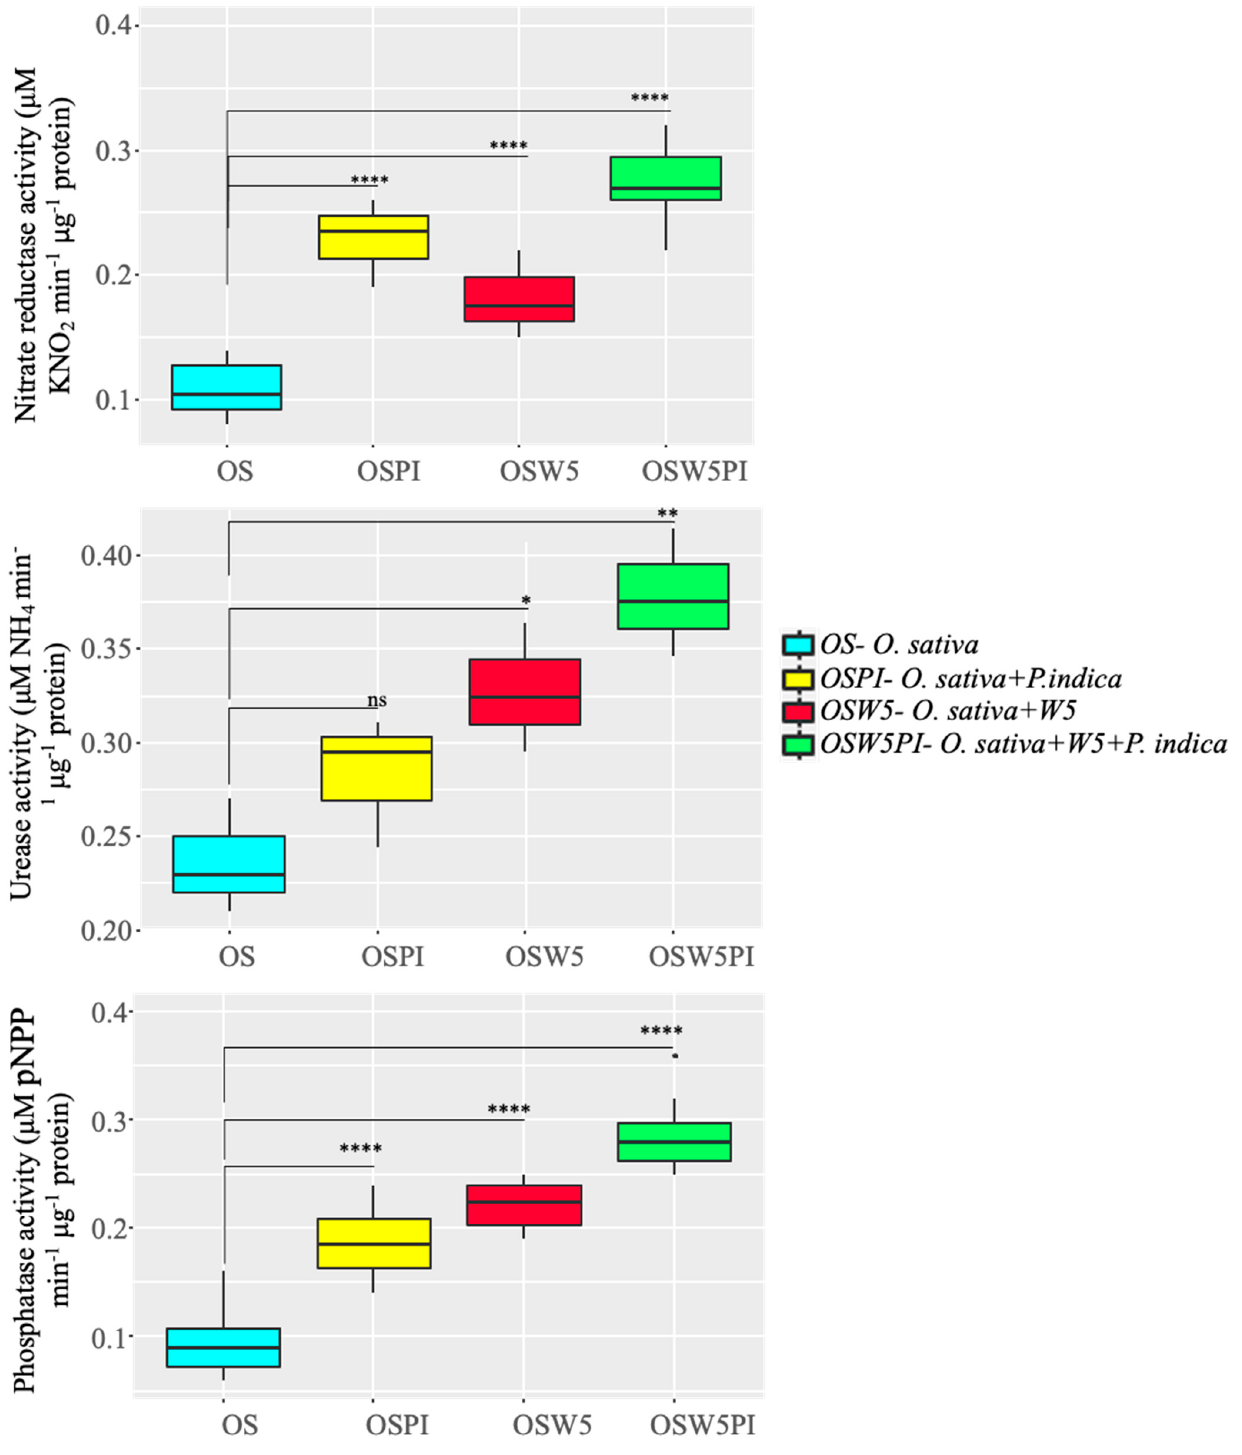
Figure 2. Impact of W5 and P. indica on nitrate reductase, urease, and phosphatase activity in O. sativa roots, after 96 HPI. Values represented as mean ± SE, n = 10, p -value (* ≤ 0.05, ** ≤ 0.01 and **** ≤ 0.0001) compared with O. sativa .